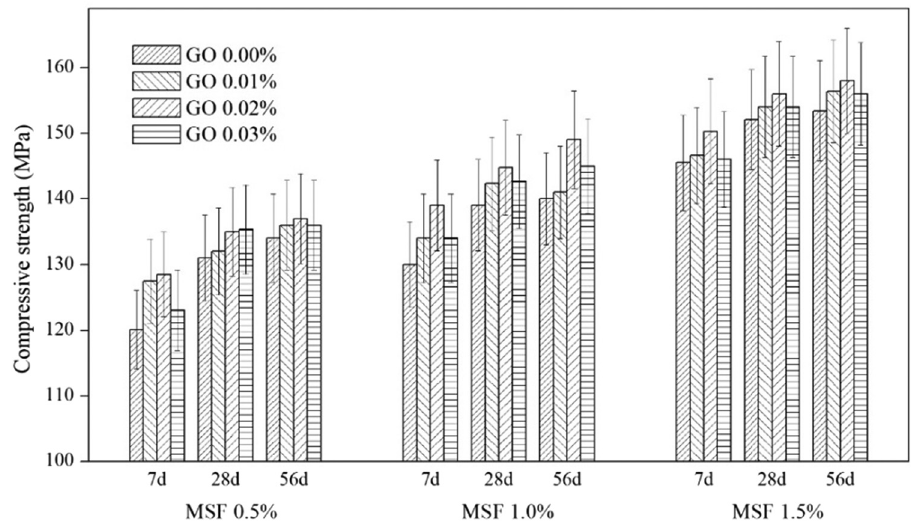
Figure 6: Compressive strength of UHPC under steam curing.